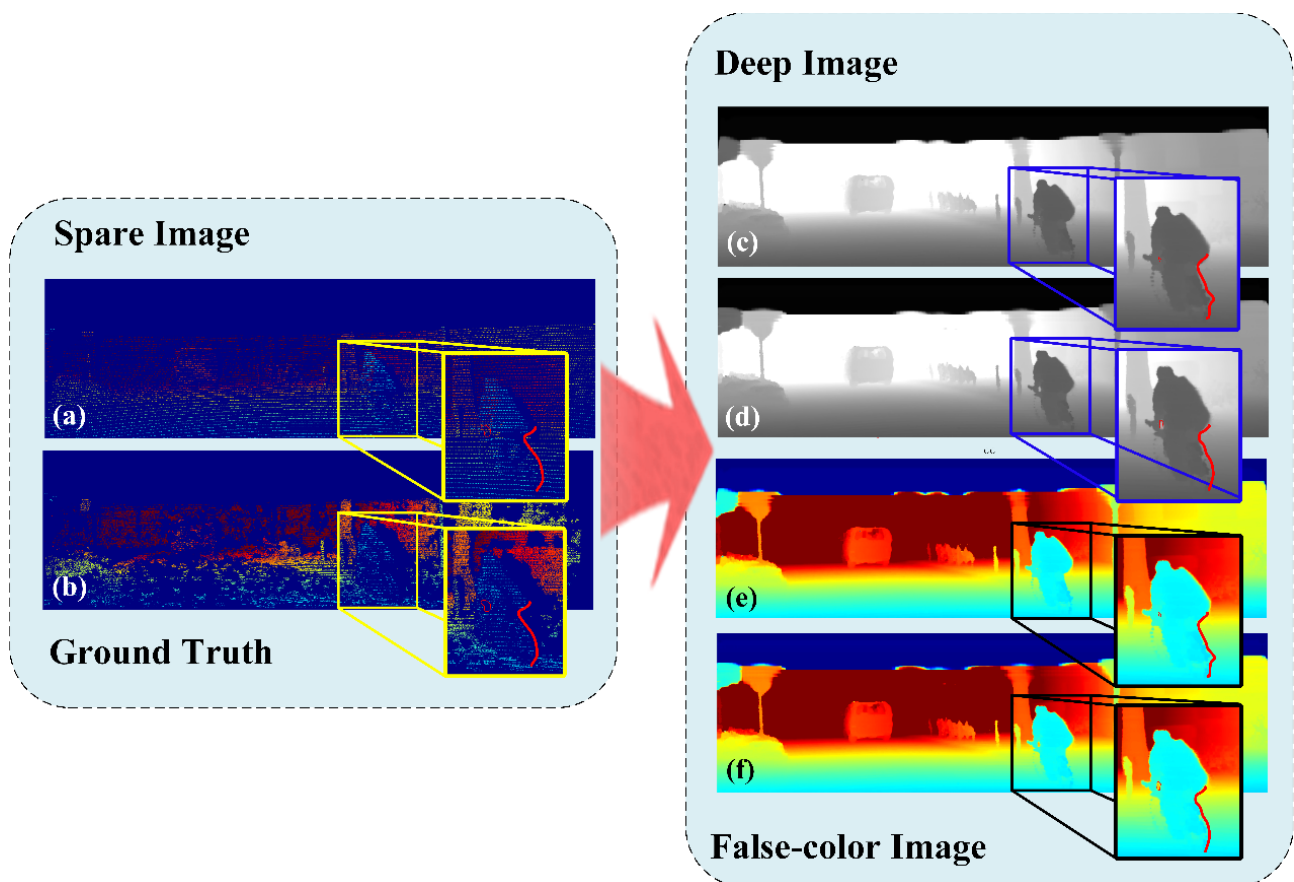
Figure 7. The effects of the confidence re-aggregation module. ( a ) is the input sparse depth image and ( b ) is the ground truth. ( c ) is the completion effect without confidence re-aggregation module and its false-color image is ( e ). ( d ) is the completion effect without the confidence re-aggregation module and its false-color image is ( f ). The red circle on the left is the gap between the man and the handlebars. The red line on the right is the curvature of the backs of people, bikes, and wheels.